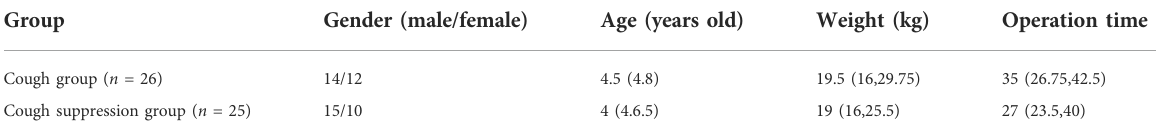
TABLE 1 Comparison of general situations between two groups of children.